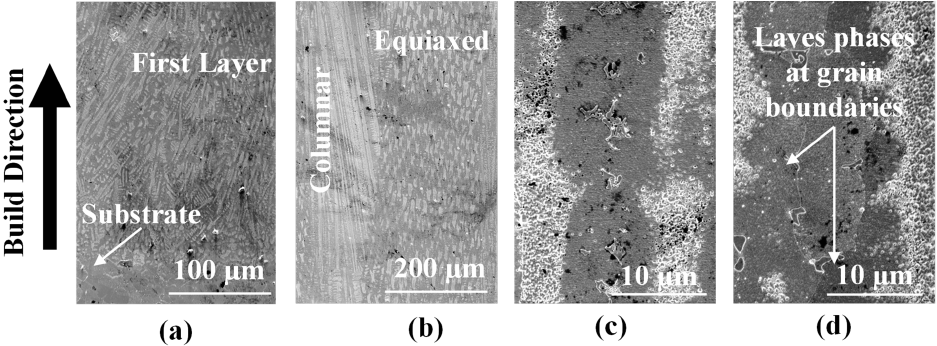
Figure 13. SEM images of the wire-fed L-DED specimen showing ( a ) the first layer adjacent to the substrate and ( b ) the middle region of the specimen where equiaxed and columnar dendrites are observed. SEM images of the ( c ) interdendritic Laves phases and ( d ) Laves phases at the grain